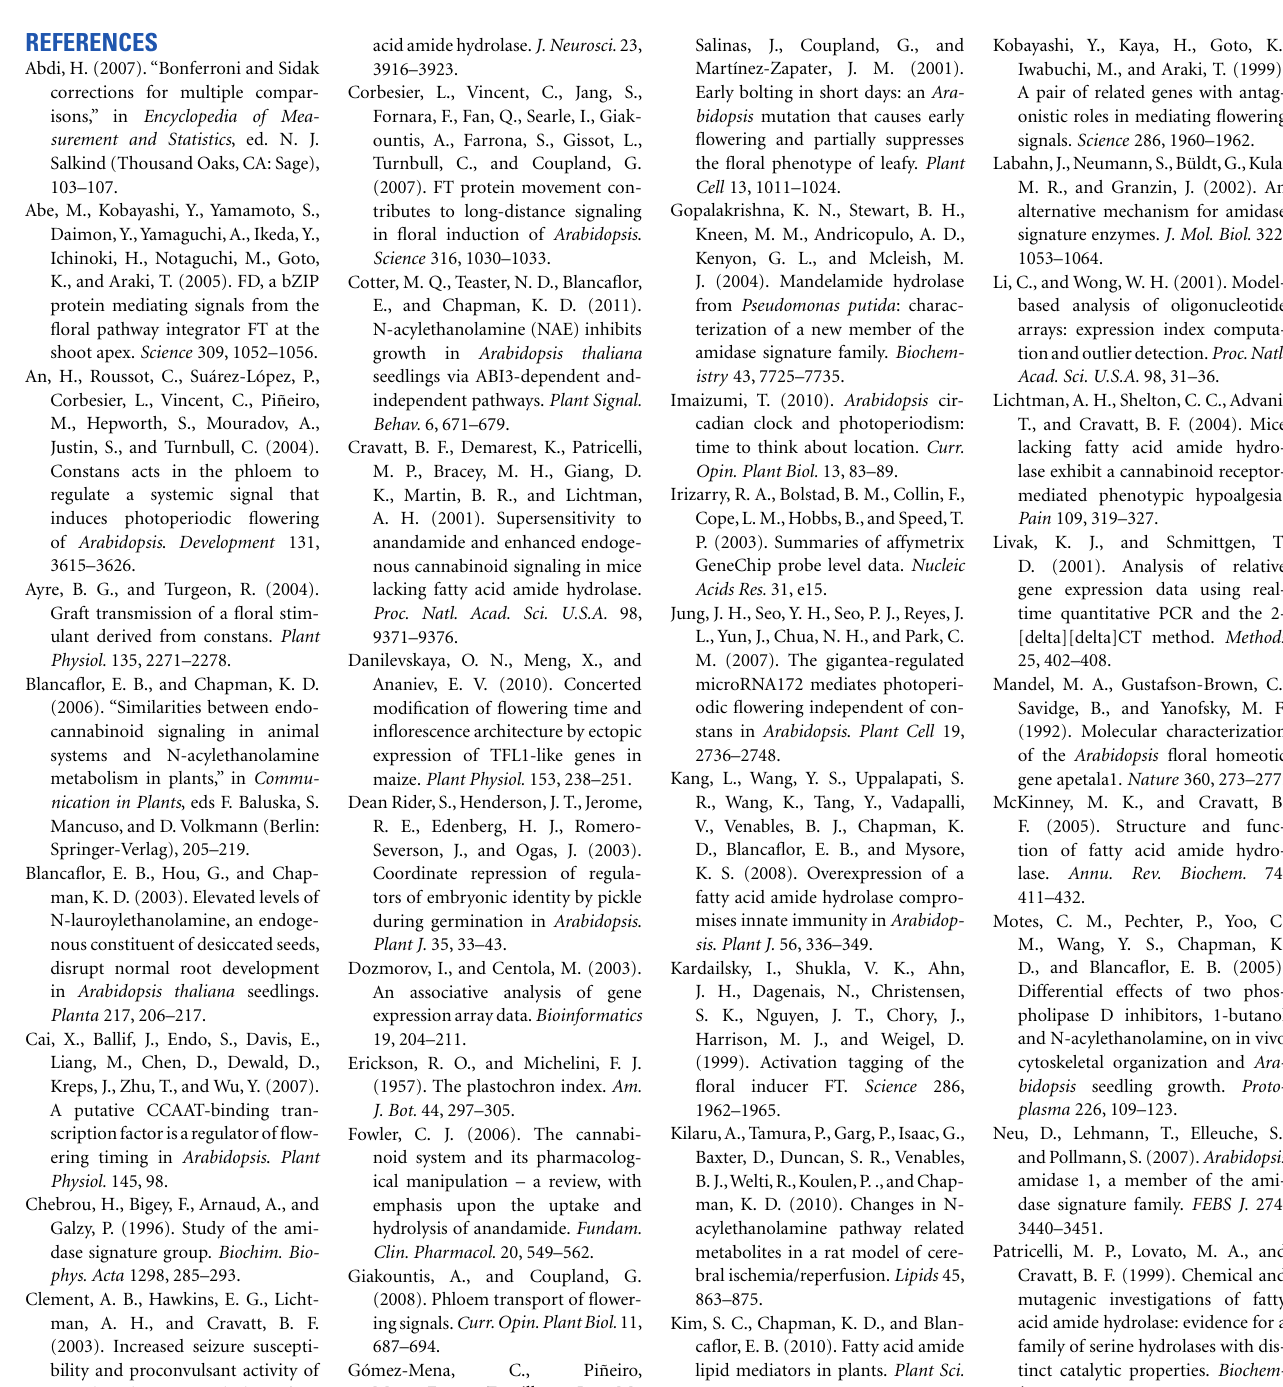
Table S1 | Differentially expressed genes in AtFAAH overexpressor and AtFAAH knockouts compared to wild type.These data were deposited with the EMBL–EBI ArrayExpress database under accession E-MEXP-3486.